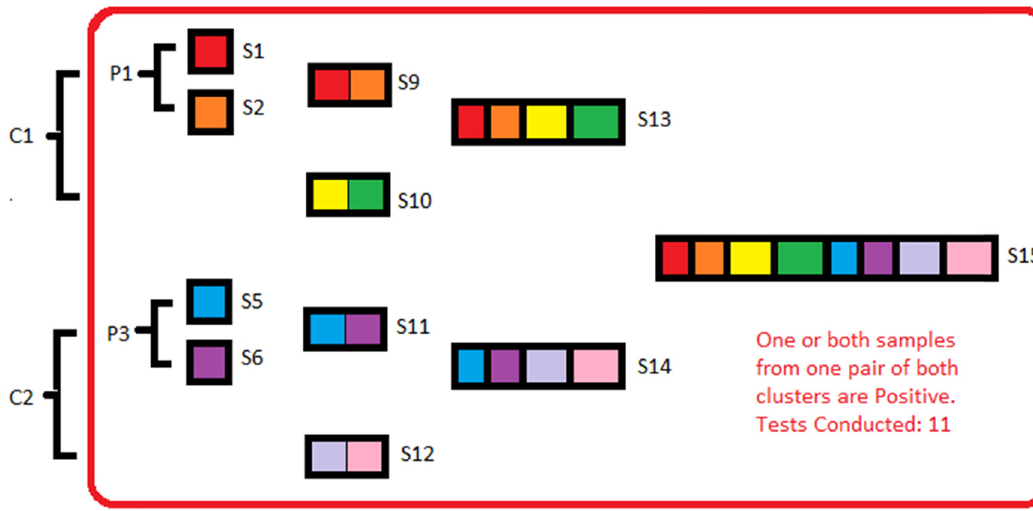
Figure 6: Eleven tests to be performed for testing eight individuals.